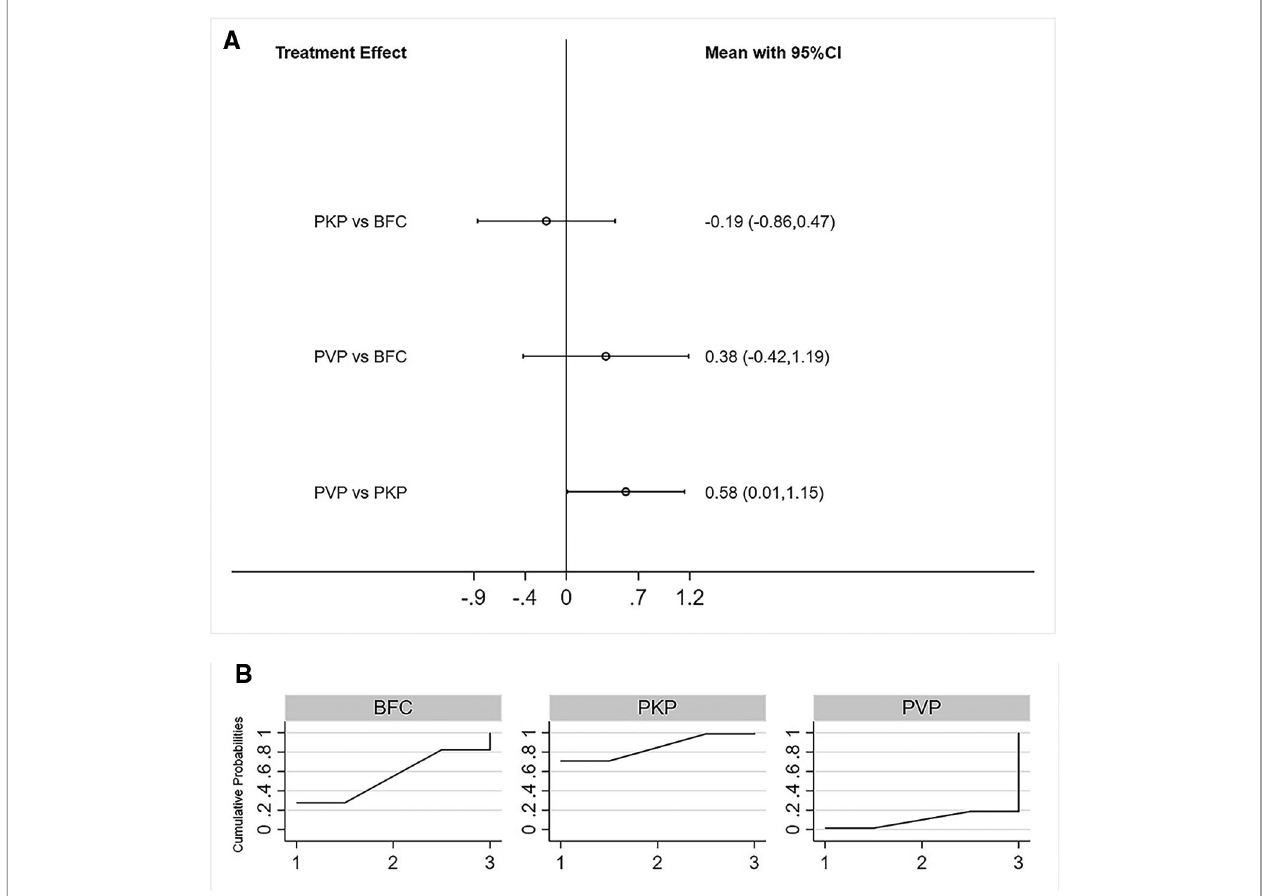
FIGURE 4 | Forest plot of cobb angle ( A ) and relevant SUCRA of each procedure ( B ). PVP, percutaneous vertebroplasty; PKP, Percutaneous kyphoplasty; BFC, bone- fi lling mesh